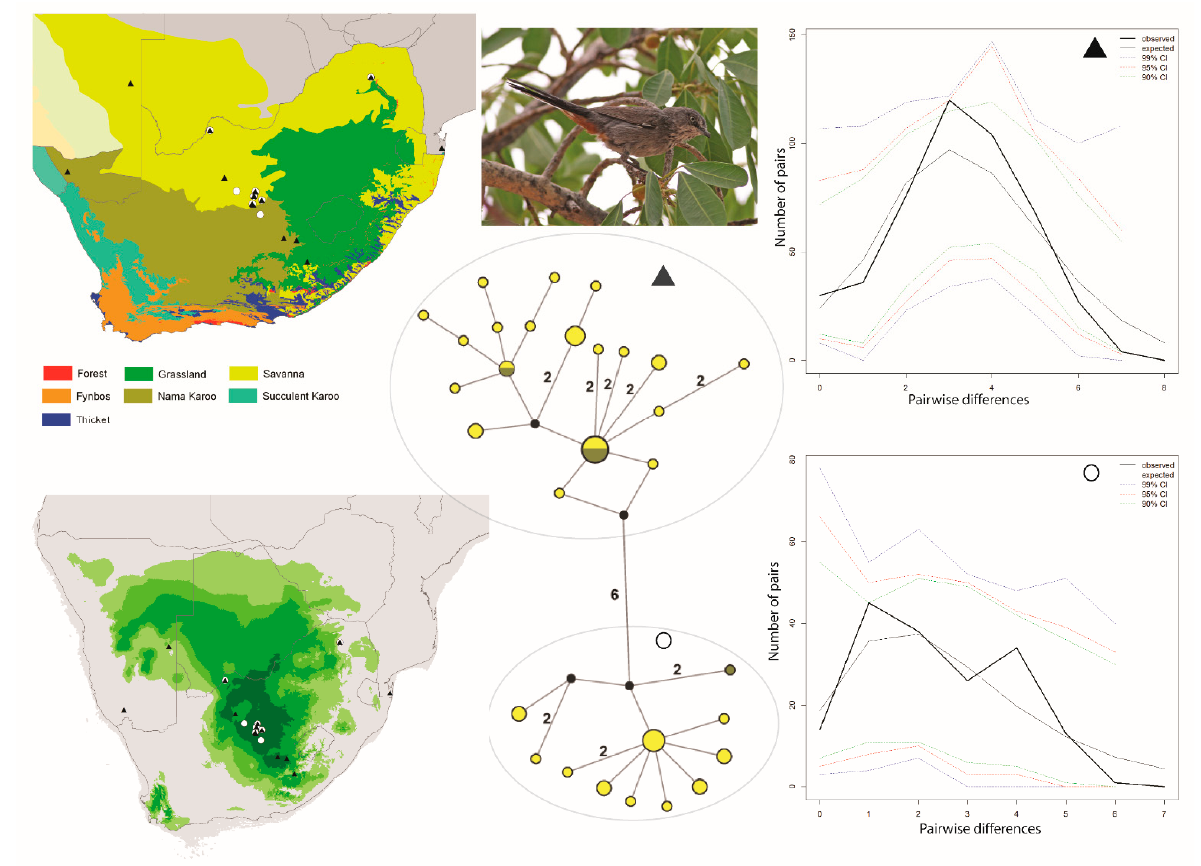
Figure 1. Maps and results from analyses of Curruca subcoerulea . The haplotype analysis ( middle bottom ) recovered two clusters, represented by O and ▲ , within southern Africa that are separated by six mutational steps; circle sizes in the networks correspond to the number of individuals with that haplotype (larger circles reflect more individuals with that haplotype), and black circles represent unsampled haplotypes. Other colors represent the biome(s) in which a haplotype was collected ( top left ); however, circle size has no relationship to the number of individuals from a given biome (if a haplotype is found in more than one biome)—in other words, just one individual from a specific biome would contribute that biome color to the circle. The geographic distributions of individuals in each haplotype cluster are depicted with respect to biome type ( top left ) and to the estimated species stability map ( bottom left ) is summed across all time slices, with darker shades of green indicating areas of higher stability. Mismatch distributions for each haplotype cluster depict demographic trends within each haplotype cluster ( right , top , and bottom ), where solid lines depict expected (black) and observed (black bold) pairwise differences, and dotted lines depict confidence intervals at 99% (blue), 95% (red), and 90% (green). Photo by Ron Knight (under prior taxonomic nomenclature: https://search.creativecommons.org/pho-